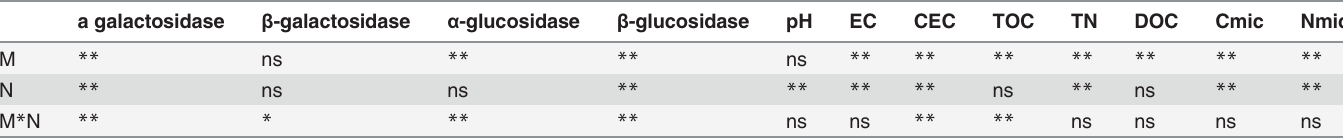
Table 2. Analysis of variance of soil enzyme activities and soil physical-chemical characteristics in the long-term manure and different levels of N fertilizer treatments under greenhouse condition. a galactosidase